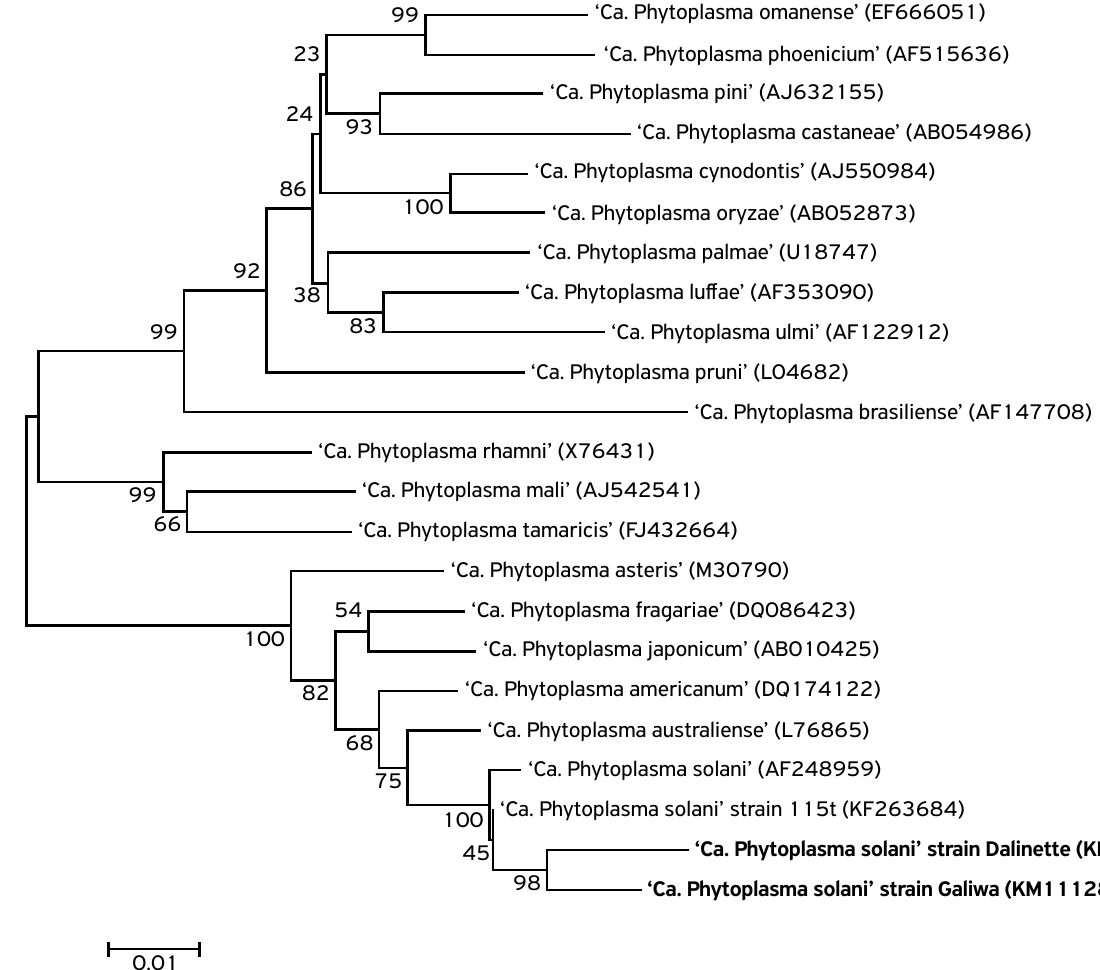
Figure 2. Phylogenetic tree inferred from 16S rDNA sequences using the neighbor-joining method. The percentage of replicate trees, in which the associated taxa clustered together in the bootstrap test (1,000 replicates), is shown next to